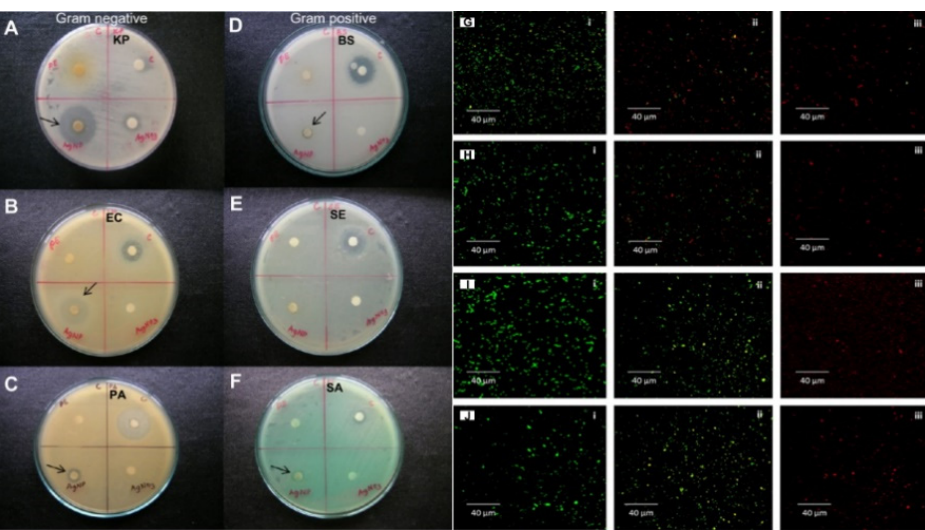
Figure 5. The efficacy of the aqueous extracts of Chrysanthemum indicum, AgNO3, and AgNPs against both gram-negative ( A – C ) and gram-positive ( D – F ) bacteria. Abbreviations: PE—plant ex- tract; C—control (streptomycin); KP- Klebsiella pneumoniae ; AgNP—silver nanoparticle; EC— Esche- richia coli ; PA— Pseudomonas aeruginosa ; BS— Bacillus subtilis ; SE— Staphylococcus epidermidis ; SA— Staphylococcus aureus ; MTCC—Microbial Type Culture Collection and Gene Bank. Reprinted